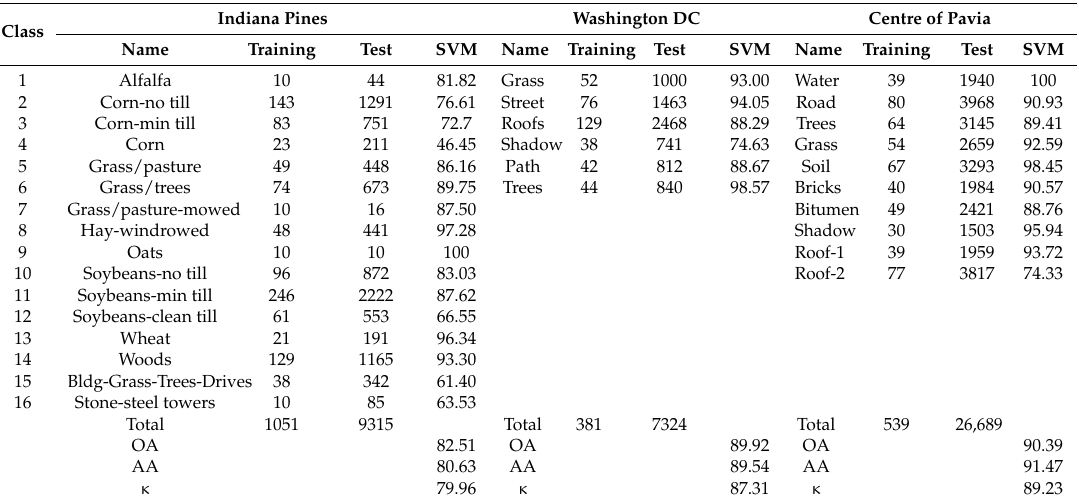
Table 1. Number of training and test samples and the GAs and CAs (percent) for all the hyperspectral data sets using the SVM classification